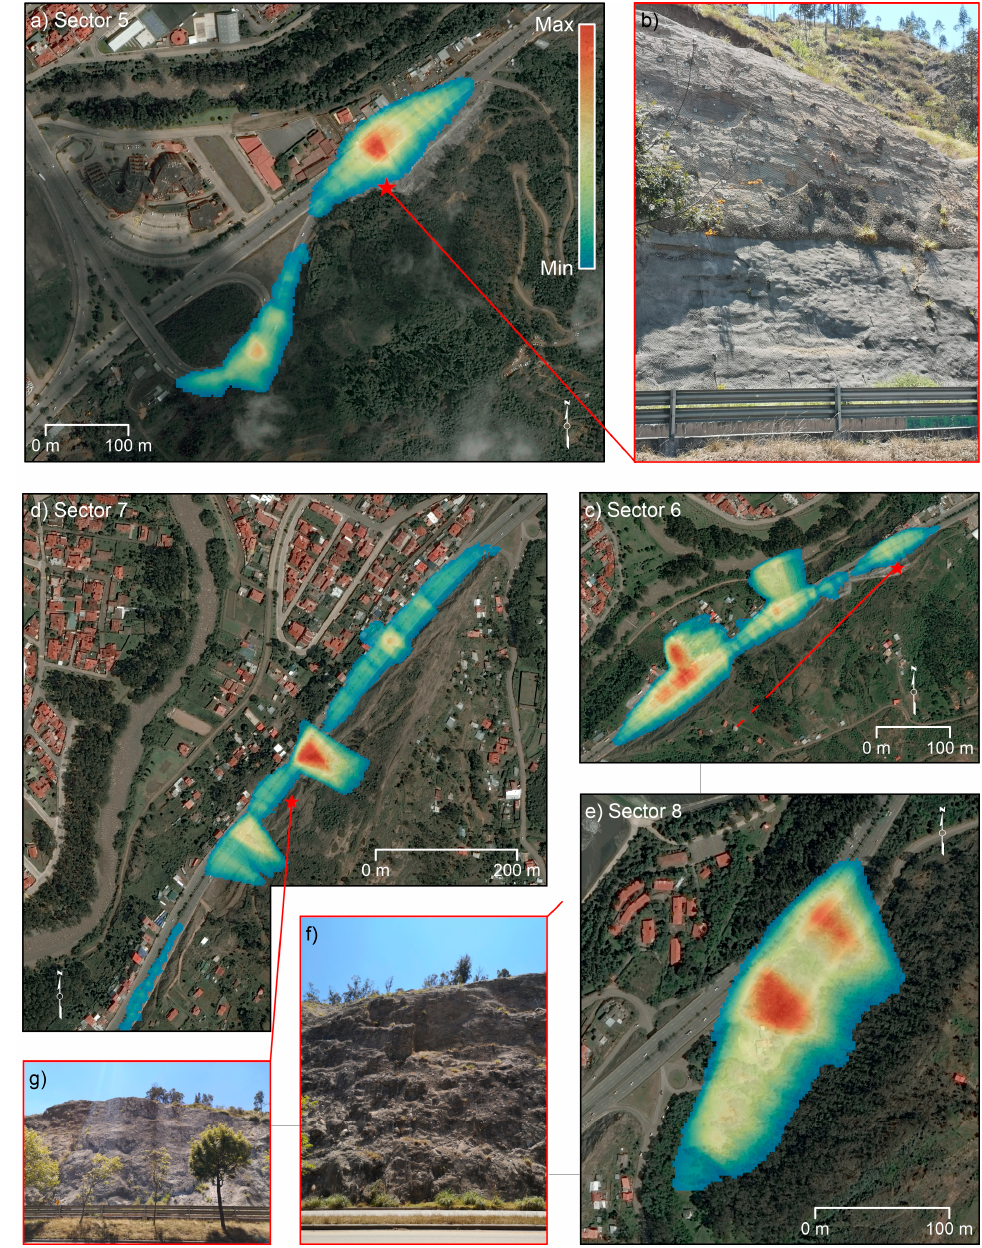
Figure 9. Outcomes of QPROTO algorithm for sector n° 5 ( a ), 6 ( c ), 7 ( d ), 8 ( e ) with different classes of potential rockfall runout occurrences; pictures ( b ), ( f ), and ( g ) show the slopes prone to collapse for sectors 5, 6, and 7, respectively.